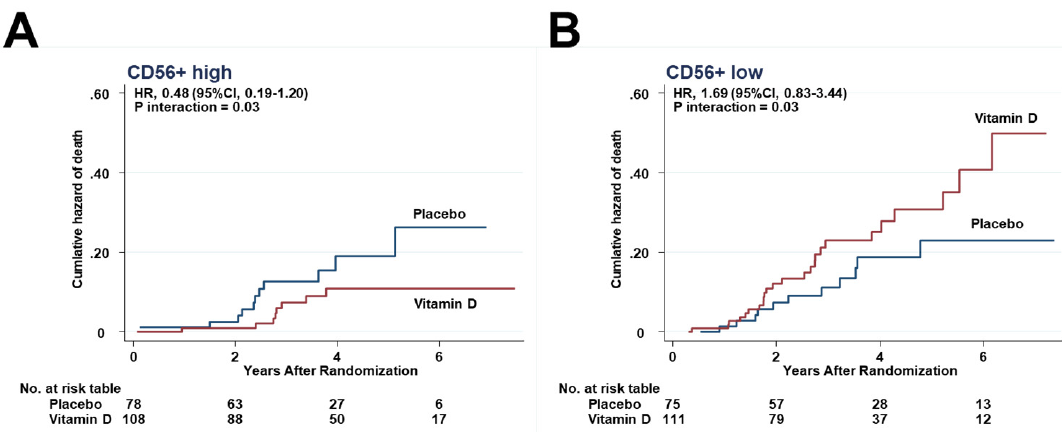
Figure 7. Effect of vitamin D on death in the subgroups of ( A ) CD56+ higher half, and ( B ) CD56+ lower half. Other interactions were not significant in the subsets of CD3+ ( P interaction = 0.18), CD4+ cells ( P interaction = 0.67), CD8+ ( P interaction = 0.26), and CD45RO+ ( P interaction = 0.19). Similar analyses for each subset of tumor-infiltrating lymphocytes were performed and are shown in supplementary Figure S6; no significant HRs or Ps for interaction were obtained in these